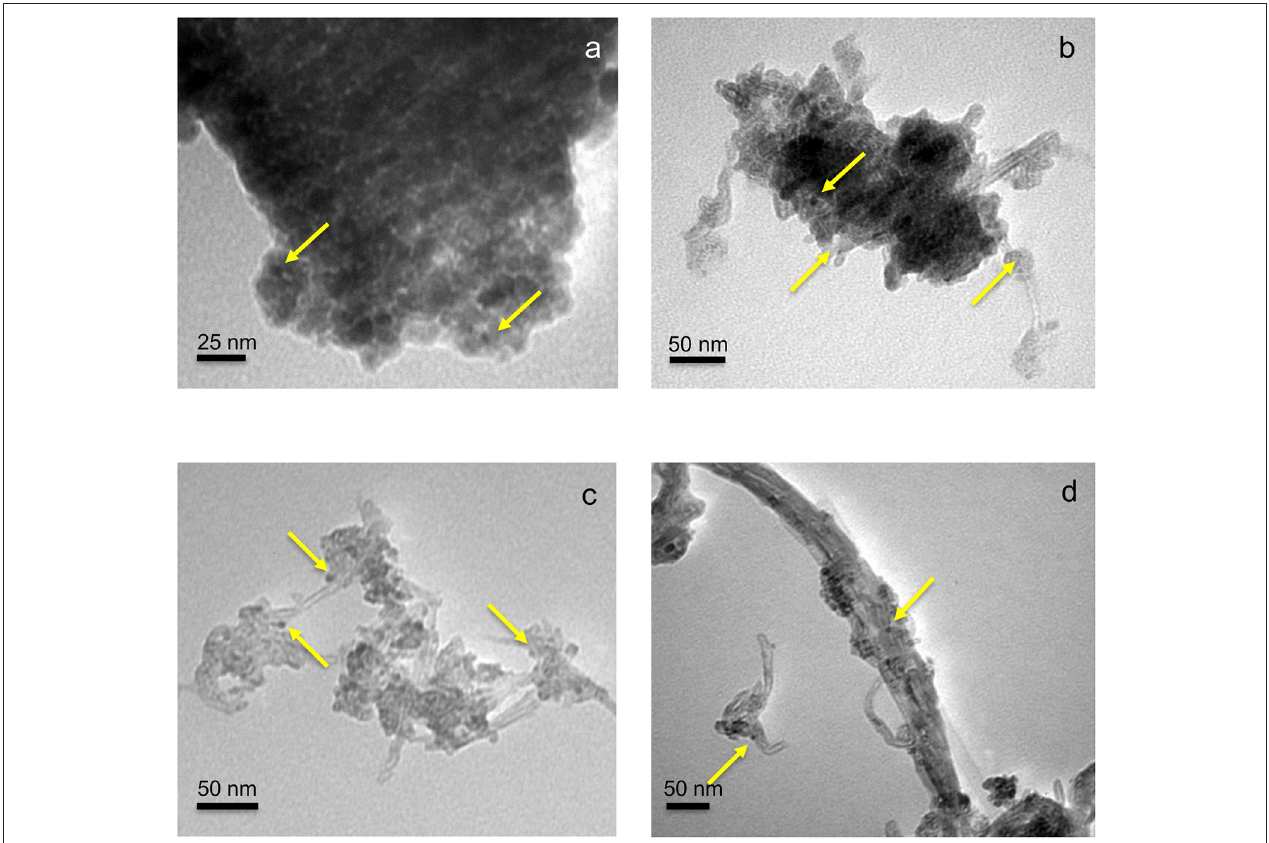
FIGURE 2 | TEM micrographs of TiO 2 (a) , 5CNT-TiO 2 (b) , 20CNT-TiO 2 (c) , and 70CNT-TiO 2 (d) loaded with 1% Cu and 1% Pd ( wt. %). The arrows indicate the presence of metal nanoparticles.